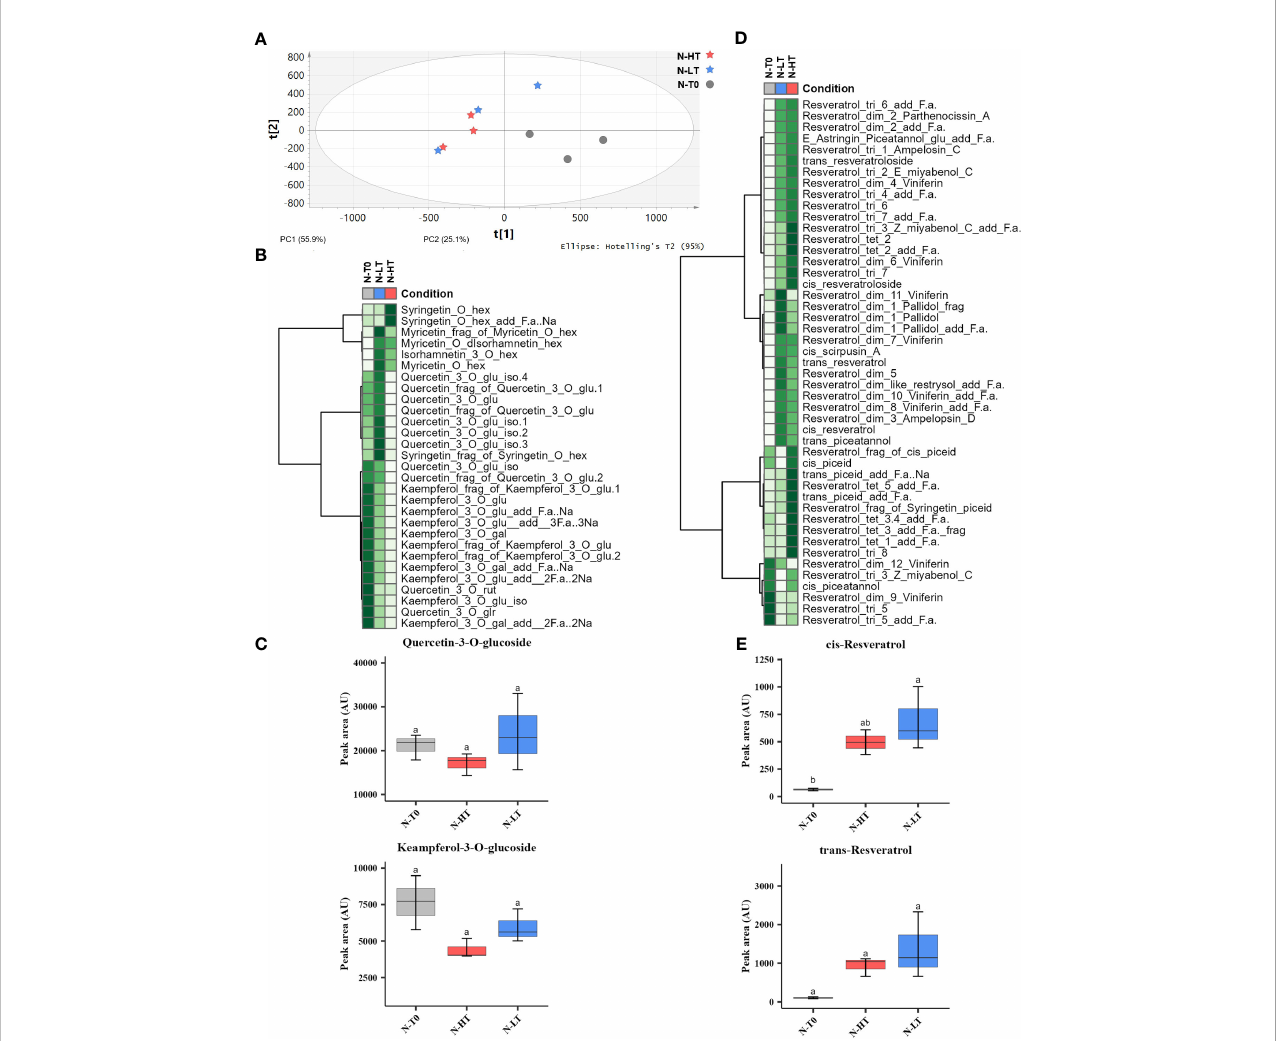
FIGURE 8 Metabolic pro fi le and variation of stilbenes and fl avonols in berries following dehydration in the N-HT and N-LT withering facilities. (A) PCA score scatter plot of non-volatile metabolites from berries collected at harvest (T0) and at the end of withering under N-HT and N-LT conditions. (B) Heatmap and Hierarchical Cluster Analyses performed on fl avonols scaled peak areas (AU) measured at T0 and at the end of withering in the N-HT and N-LT conditions. Green and white colors represent high and low peak area values, respectively. Pearson correlation coef fi cient was employed to group the different metabolites, using average as clustering algorithm. Abbreviations: add=adduct; frag=fragment; f.a.=formic acid; gal=galactoside; glr=glucuronide; glu=glucose; hex=hexoside; iso=isotope; rut=rutinoside. (C) Quercetin-3-O-glucoside and kaempferol-3-O-glucoside accumulation during withering in high and low temperature conditions. Lowercase letters represent statistically signi fi cant difference based on ANOVA and Tukey post-hoc test with p ≤ 0.05. (D) Heatmap and Hierarchical Cluster Analyses preformed on the stilbenes. Abbreviations: add=adduct; dim=dimer; frag=fragment; f.a.=formic acid; gal=galactoside; glr=glucuronide; glu=glucose; hex=hexoside; iso=isotope; rut=rutinoside. tri=trimer; tet=tetramer. (E) Cis-resveratrol and trans-resveratrol accumulation during withering in high and low temperature conditions. Lowercase letters represent statistically signi fi cant difference based on ANOVA and Tukey post-hoc test with p ≤ 0.05. Gray colour indicates grapes at harvest (T0); light blue colour indicates the N-LT condition; light red colour indicates the N-HT